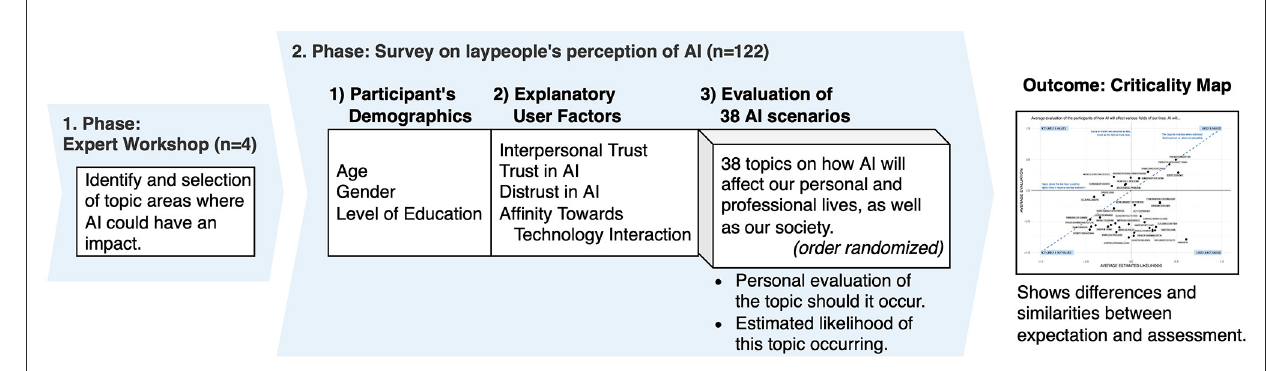
FIGURE1 Multi-stage research design of this study with expert workshop and subsequent survey study. The questionnaire captures demographics, exploratory user factors and the evaluation of the 38 AI-related scenarios.